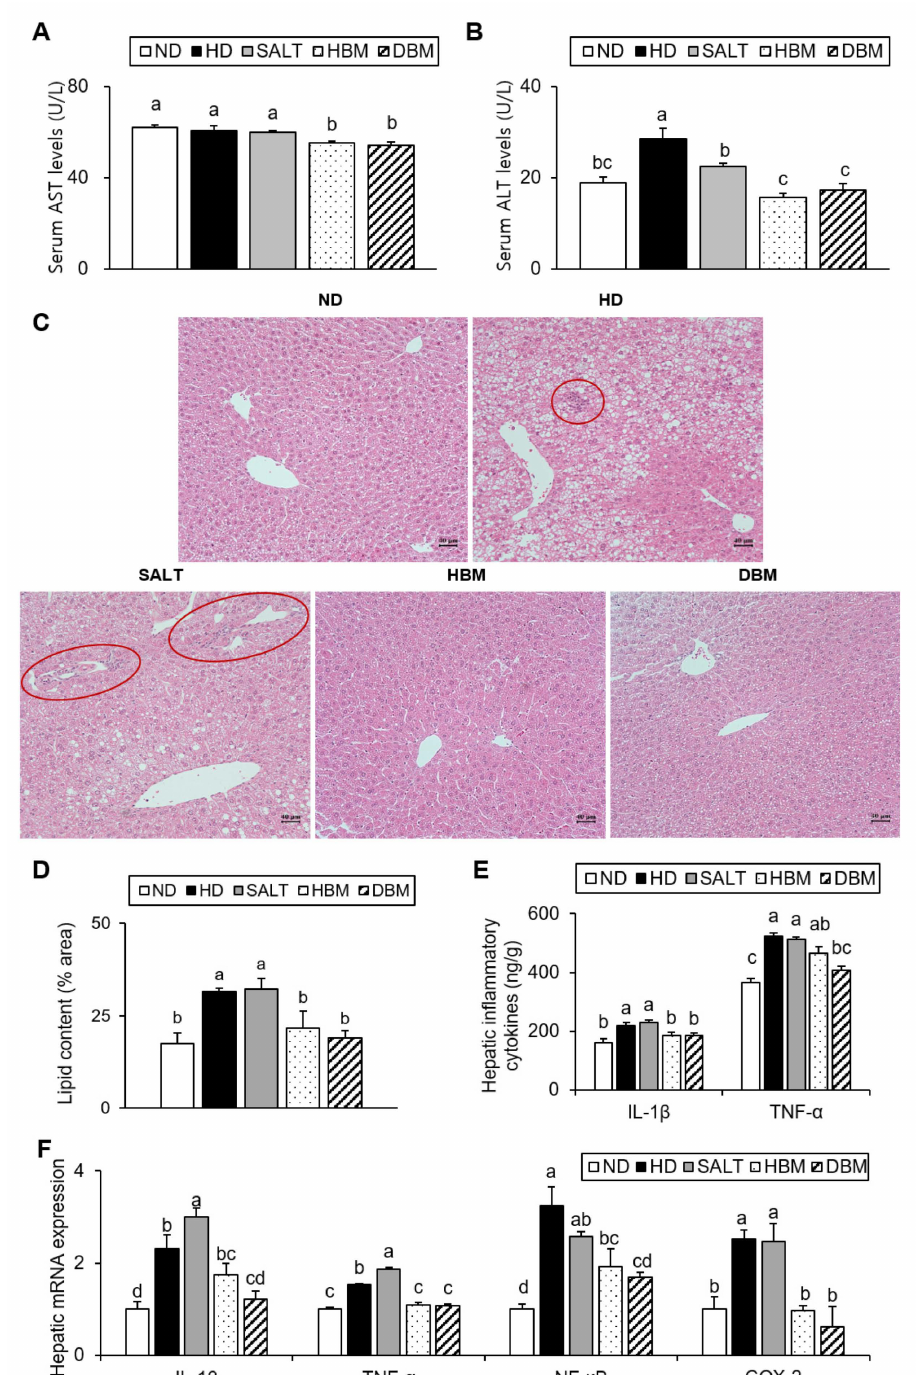
Figure 4. Effects of Gochujang on hepatic lipid accumulation and inflammation in the HD-fed mice. ( A ) Serum AST level; ( B ) Serum ALT level; ( C ) Histological analysis (200 × ) of liver tissues by H&E staining (red circle area showed periportal mononuclear leukocytic infiltration); ( D ) quantitation of liver lipid content shown as percentage of the total histological area; ( E ) Hepatic levels of IL-1 β and TNF- α ; ( F ) Relative mRNA expression of IL-1 β , TNF- α , NF-kB, COX-2 in liver tissue. Values are mean ± SEM. a–d means with the different letters on the bar ( p < 0.05). (a > b > c > d). ND, normal diet group; HD, high-fat diet group; SALT, HD with 0.7% salt group; HBM, HD with 10% of HBM Gochujang group; DBM, HD with 10% of DBM Gochujang group; AST, Aspartate aminotransferase; ALT, Alanine aminotransferase; IL, interleukin; TNF- α , tumor necrosis factor alpha; NF- κ B, nuclear factor kappa B; COX-2,